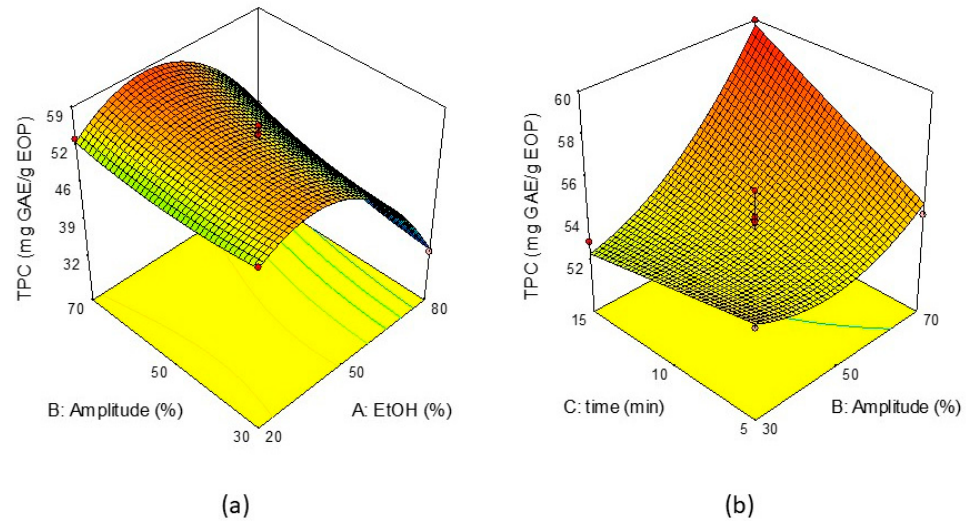
Figure 2. Response surfaces of the total phenolic compounds (TFC) as functions of the ( a ) ethanol concentration and amplitude (time: 10 min) and the ( b ) amplitude and extraction time (ethanol concentration: